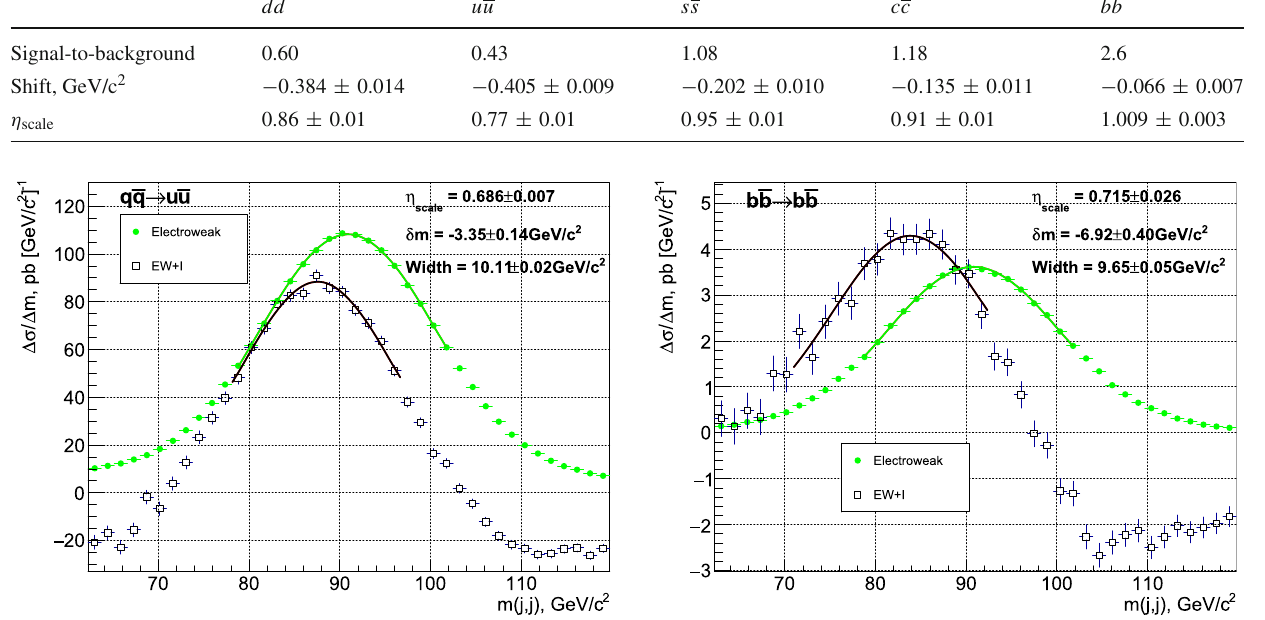
Fig. 3 Left: The process qq → uu after smearing by an assumed 10% resolution. The electroweak component is pale/green, but the hollow black points show the EW + I . Right is the same distribution for bb → bb , showing a significantly larger